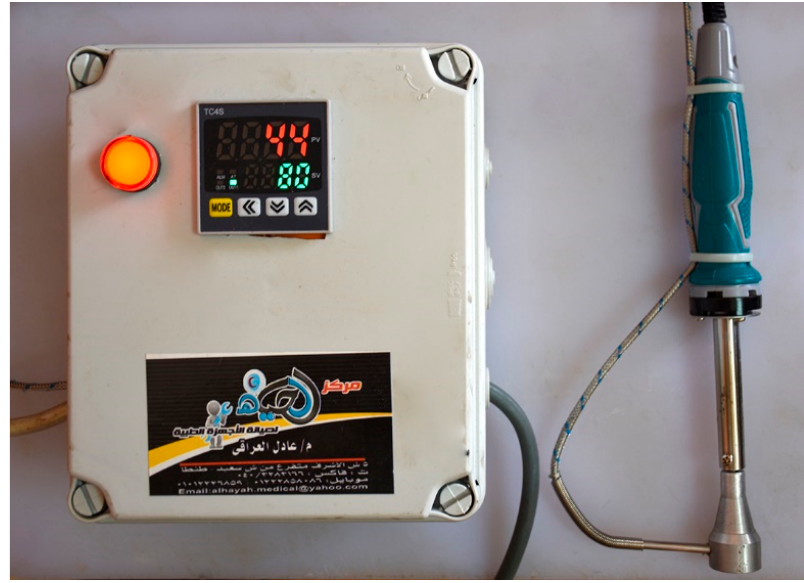
Figure 2. Adjustable electrical aluminum stamp for induction of thermal burn ‐ wounds.